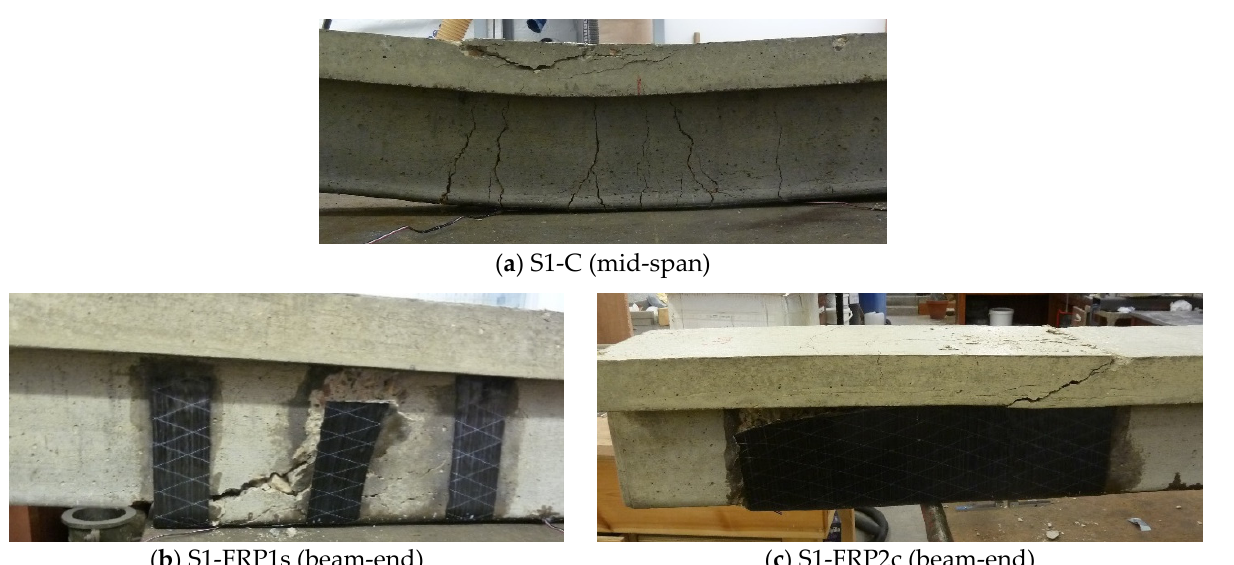
Figure 5. Observed failure in beams of series 1—( a ) S1-C, ( b ) S1-FRP1s and ( c ) S1-FRP1c.